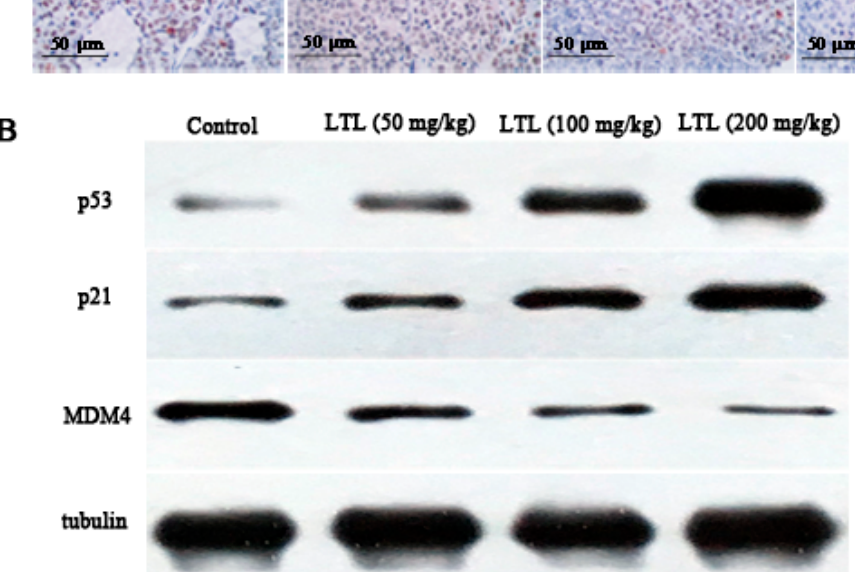
Figure 7. Effect of LTL on the expression of p53, p21, and MDM4 in Vivo. Tumor tissue sections were tested by immunohistochemistry and Western blot analysis, respectively. ( A ) Representative photographs of the tumor sections from LTL-treated groups examined by immunohistochemical staining; ( B ) Tissue lysates were separated by SDS-PAGE and analyzed on Western blots with the indicated antibodies. Tubulin was used as a loading control.